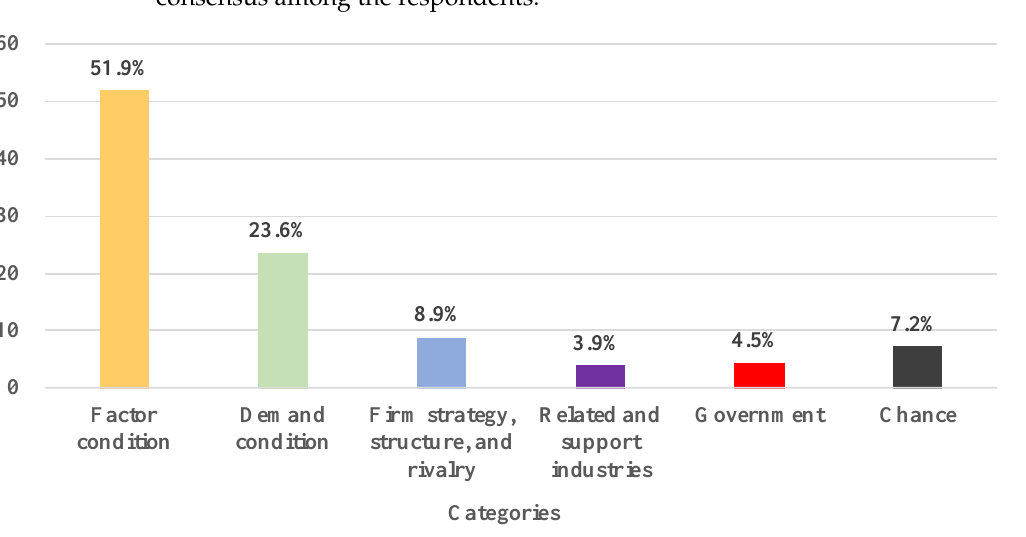
Figure 2. Relative importance of the six categories.